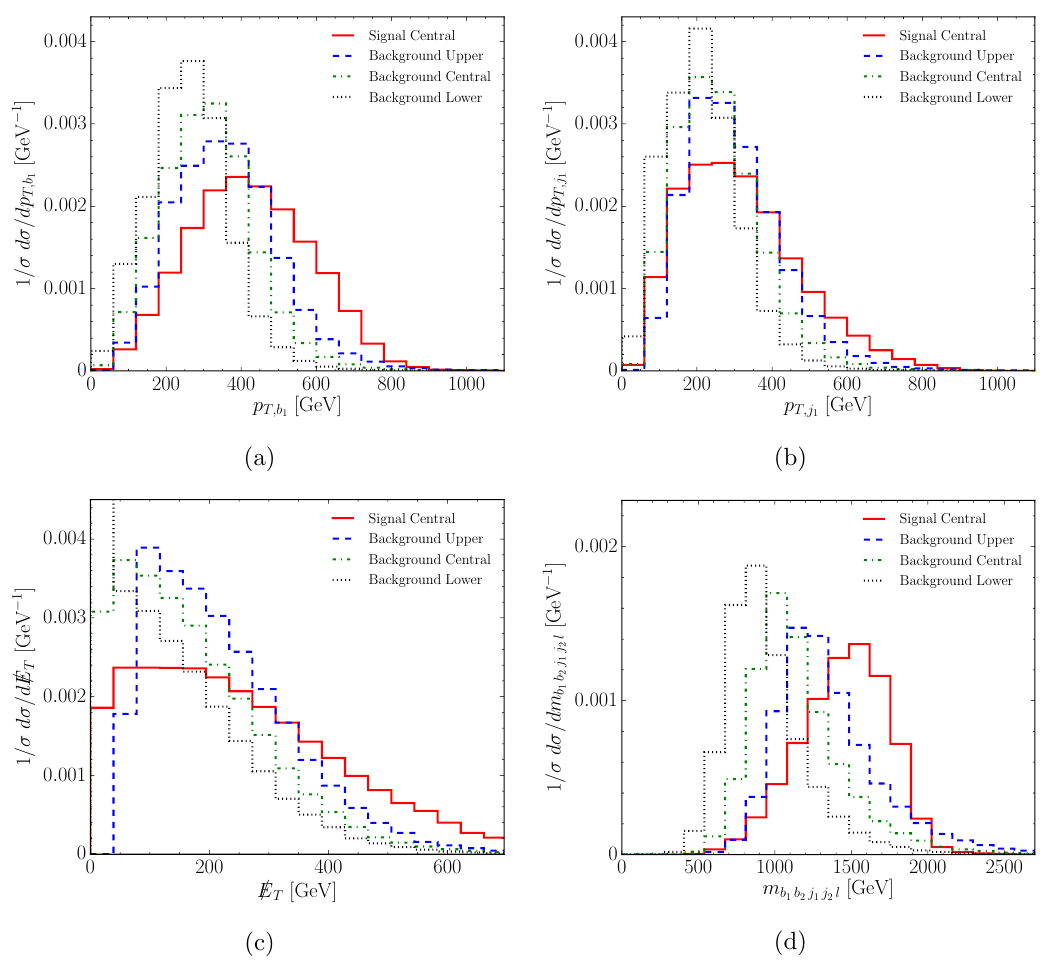
Figure 1. E(cid:11)ect of smearing on (a) the p T of the hardest b -jet, (b) the p T of the hardest light jet, (c) the missing energy and (d) the invariant mass of the jets and lepton, compared to the unsmeared background and the signal